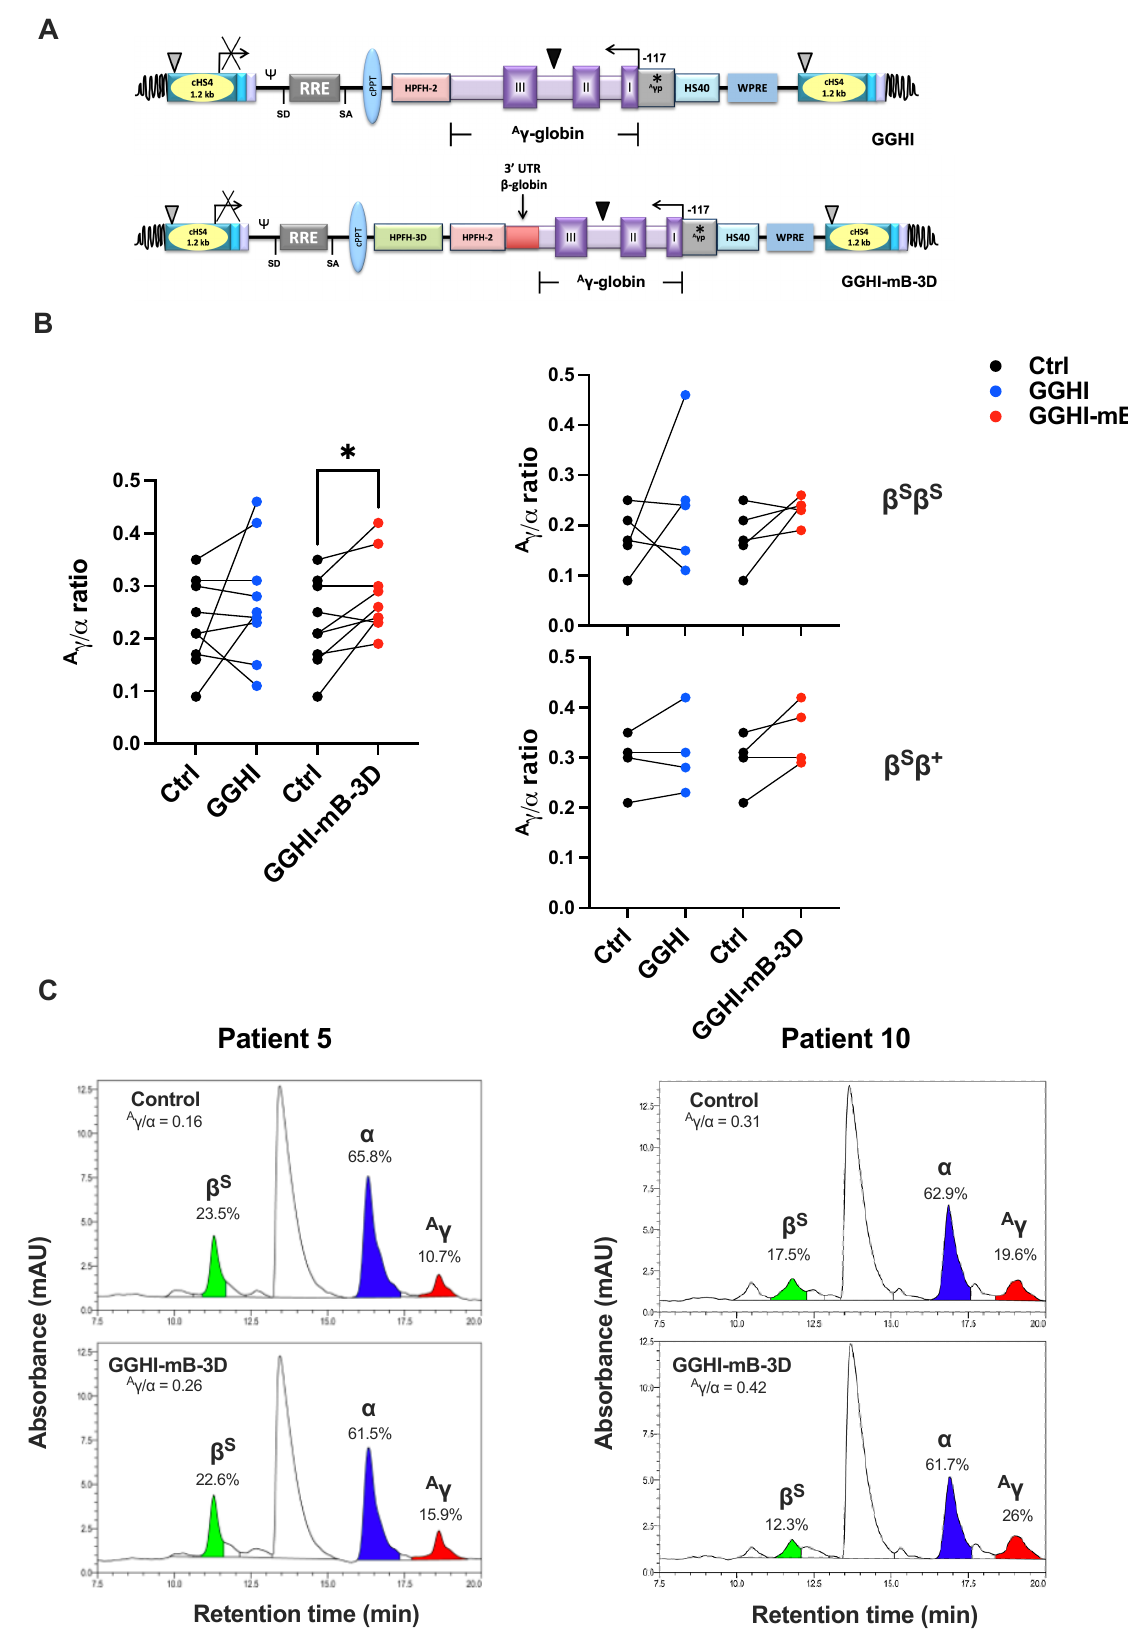
Figure 1. In vitro assessment of γ -globin lentiviral vectors (LVs) in SCD CD34 + cells: ( A ) The structure and the individual regulatory elements of the GGHI and GGHI-mB-3D LVs shown as proviral